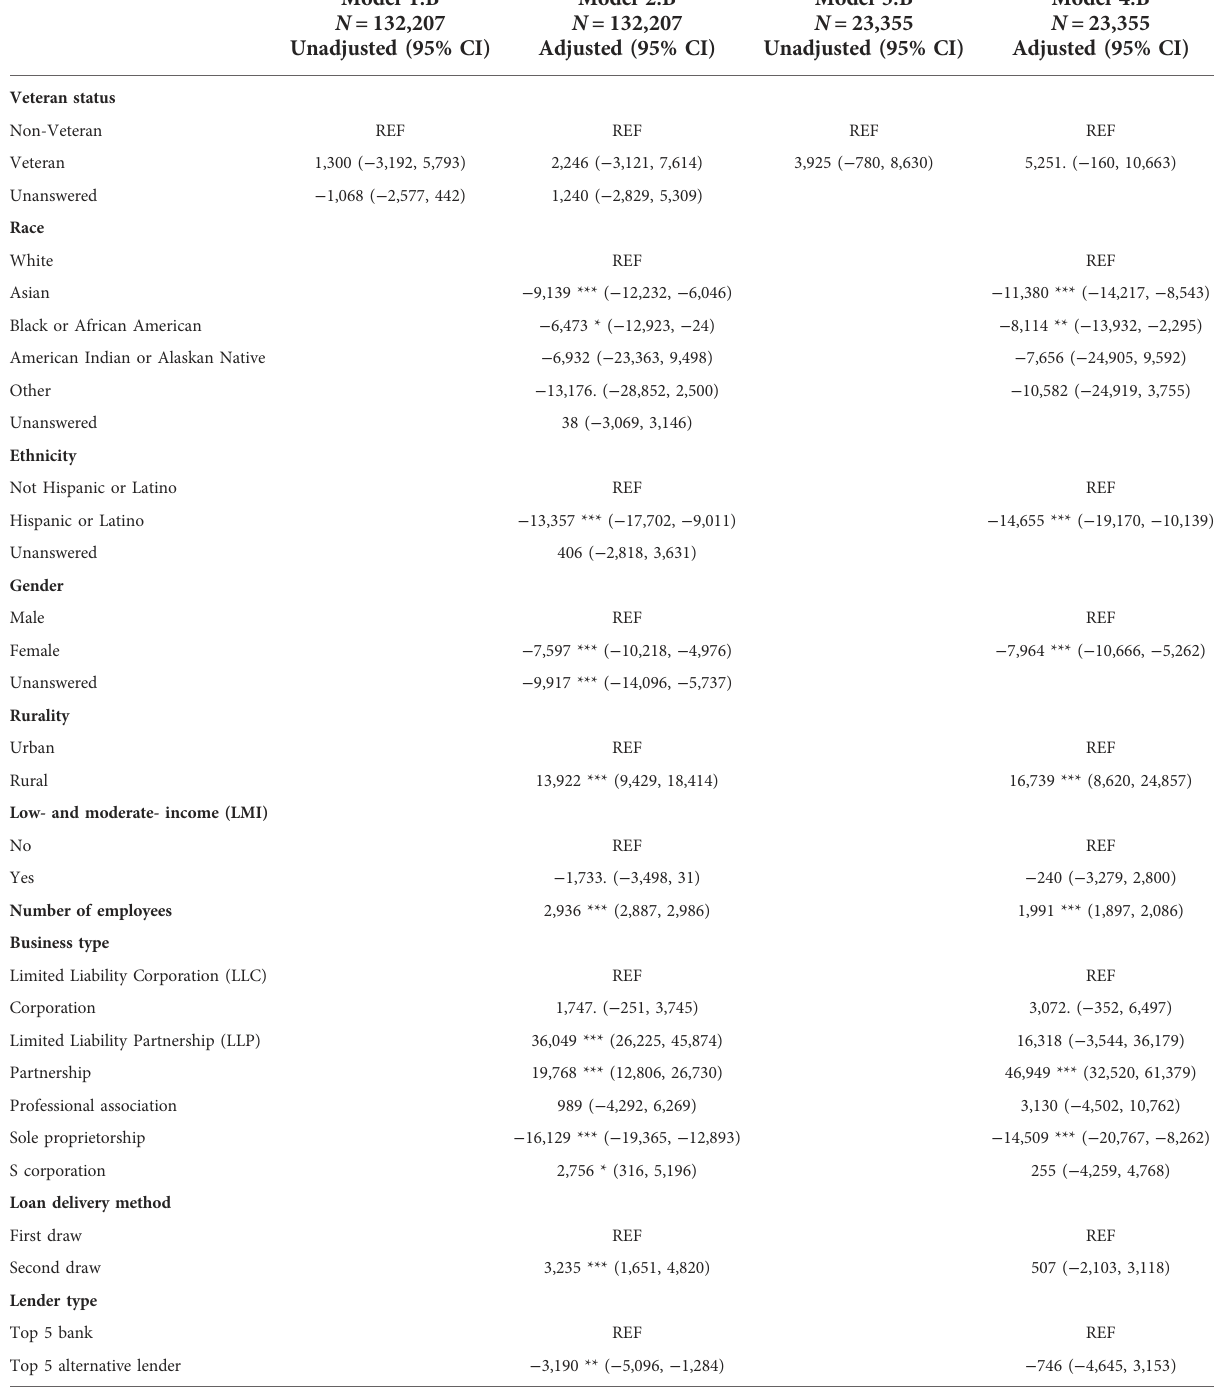
TABLE 4 Associations between paycheck protection program (PPP) loan forgiveness amount and veteran status and other